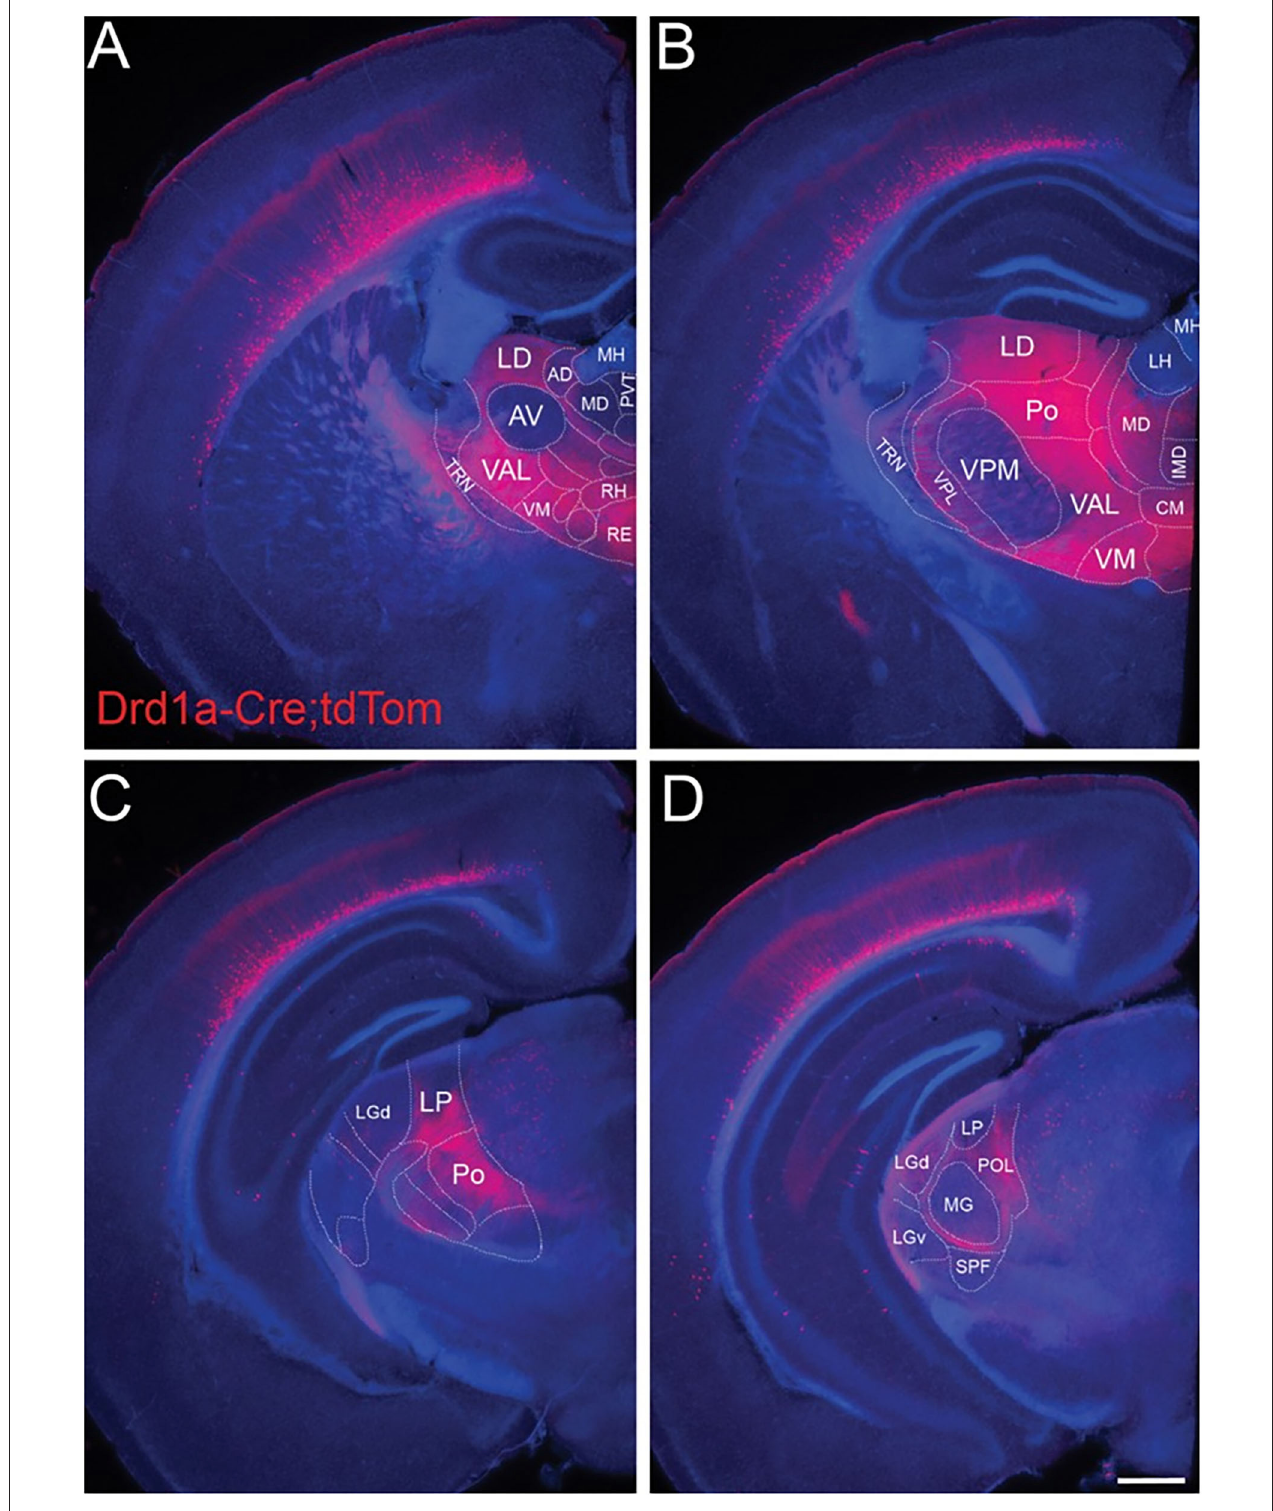
FIGURE 6 | L6b neurons project to higher order and avoid first order thalamic nuclei. Drd1a-Cre expression in fibers arising from neurons in L6b of the entire cortical mantle in adult mice (P35) visualized by tdTomato labeling (Drd1a-Cre::tdTom + fibers). Projections from L6b avoid first order auditory and non-auditory thalamic nuclei